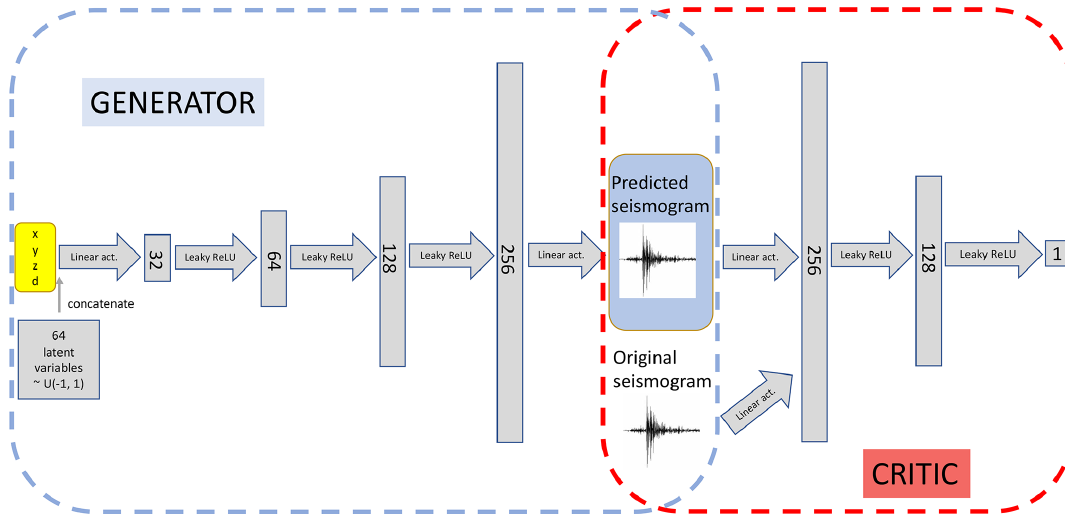
Figure 6. Schematic of the Wasserstein generative adversarial network – gradient penalty described in Sect. 2.2.7. The network is composed of a generator part (in blue) and a critic part (in red). Once the full network has been trained, the generator can be removed to be used as a generative